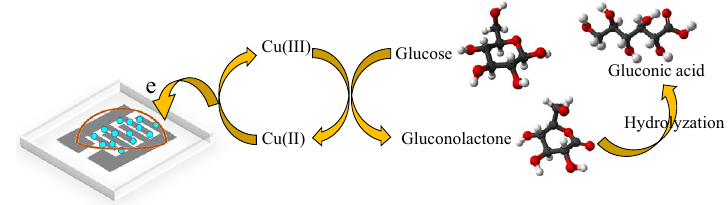
Figure 13. Schematic of the sensing mechanism of the rGO/CuO–NHS BGFET